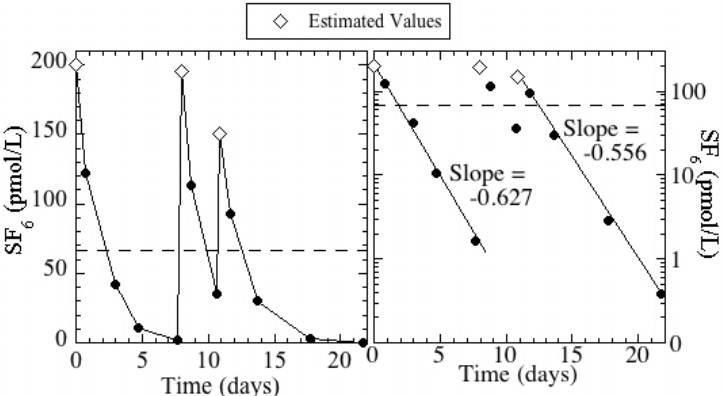
Figure 3. SF concentrations in Kraemer Basin during the injections and subsequent 6 monitoring periods. Injections occurred on days 0, 8, and 11; estimated basin concentrations are plotted for these days. The dashed line represents the 14-day flow weighted mean concentration (66 pmol/L) during the defined injection